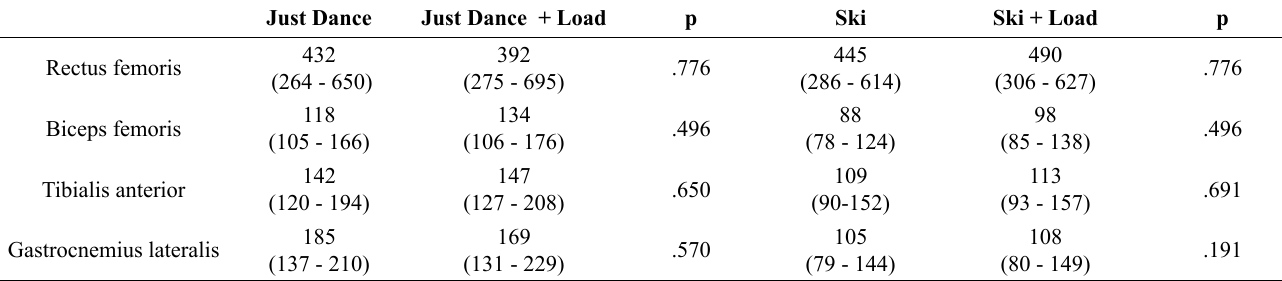
Table 2. Neuromuscular activity during Just Dance and Ski exergames with and without an additional load. Just